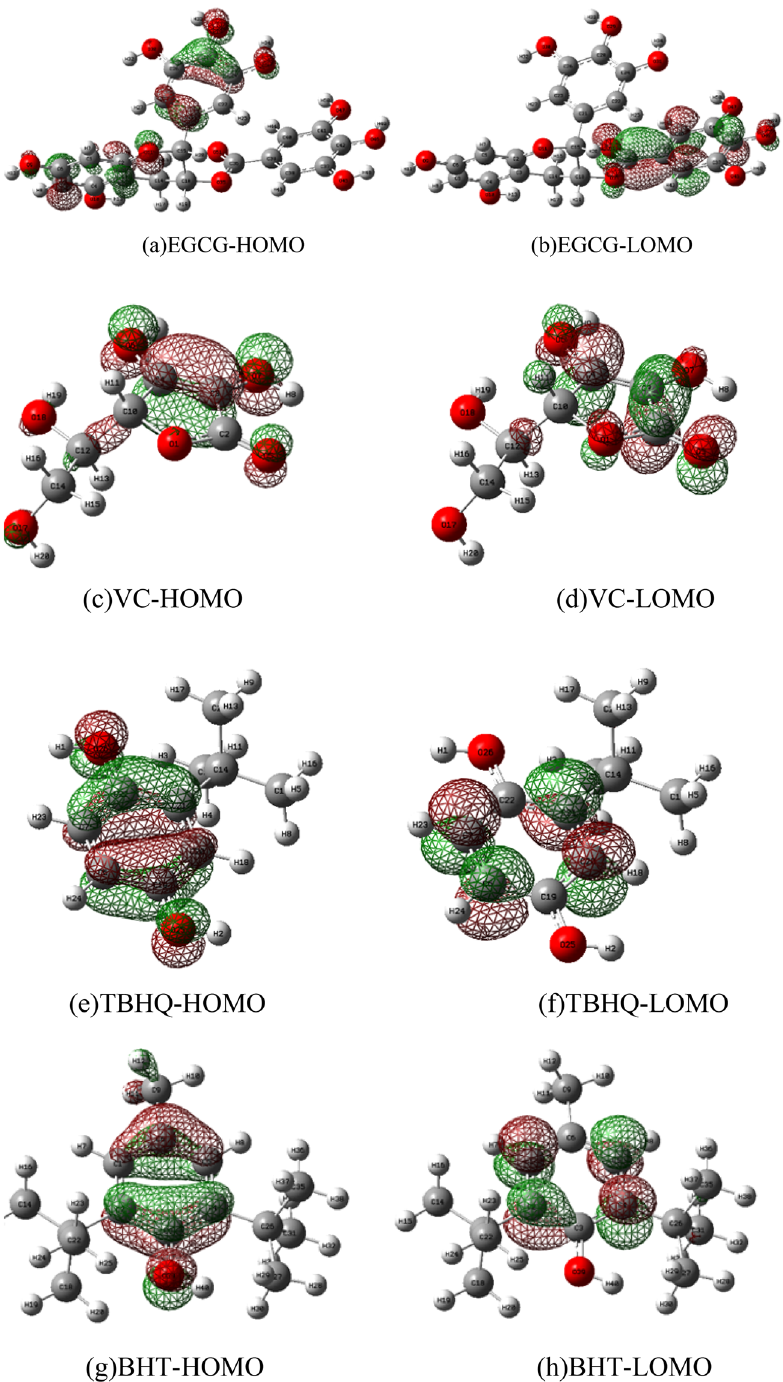
Figure 7. Frontier molecular orbitals of